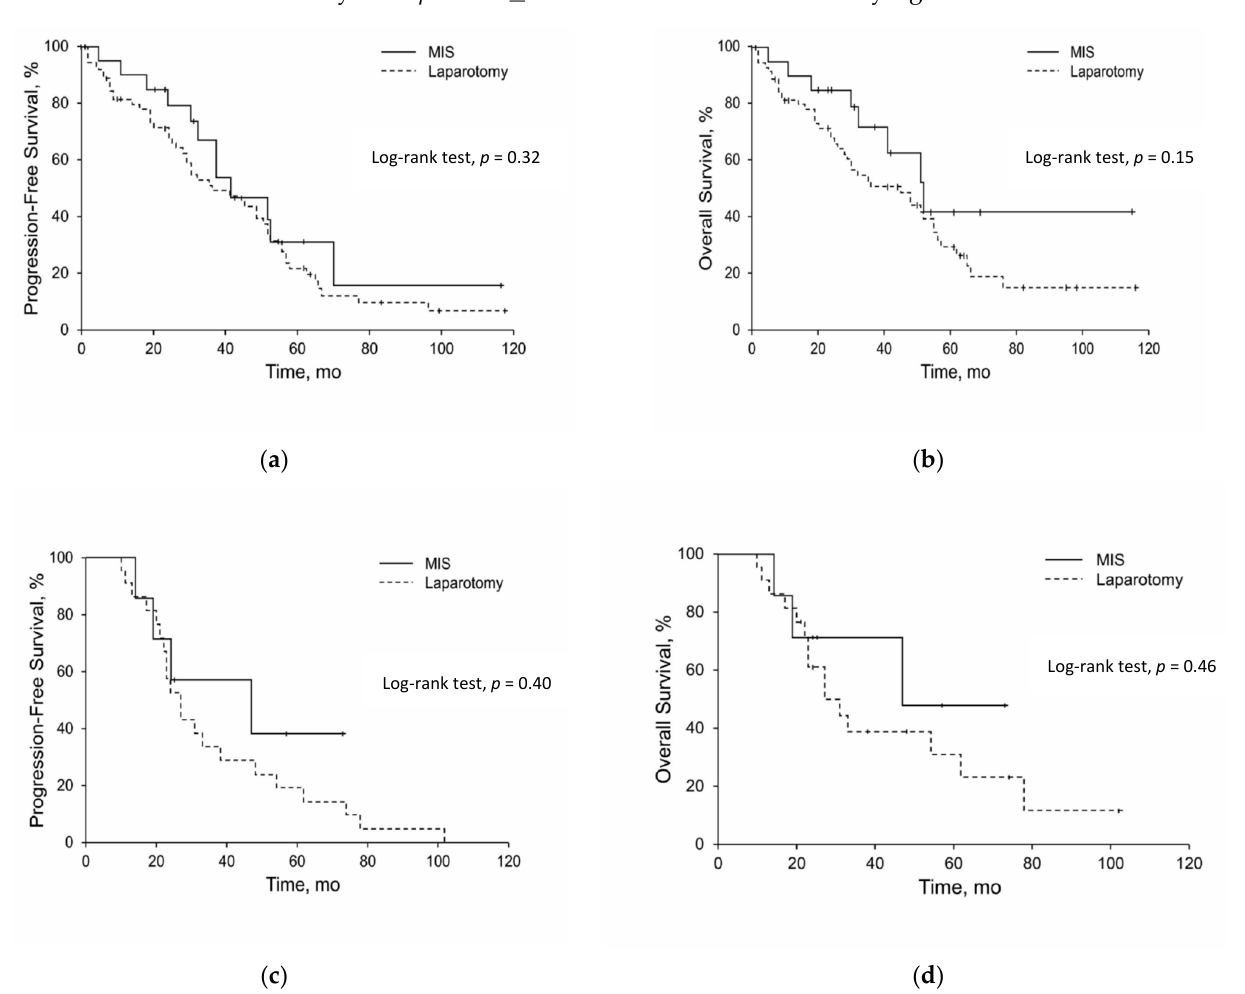
Figure 1. Comparisons of progression-free and overall survival: ( a ) progression-free survival for primary debulking; ( b ) overall survival for primary debulking; ( c ) progression-free survival for interval debulking; ( d ) overall survival for interval debulking. MIS indicates minimally invasive surgery.